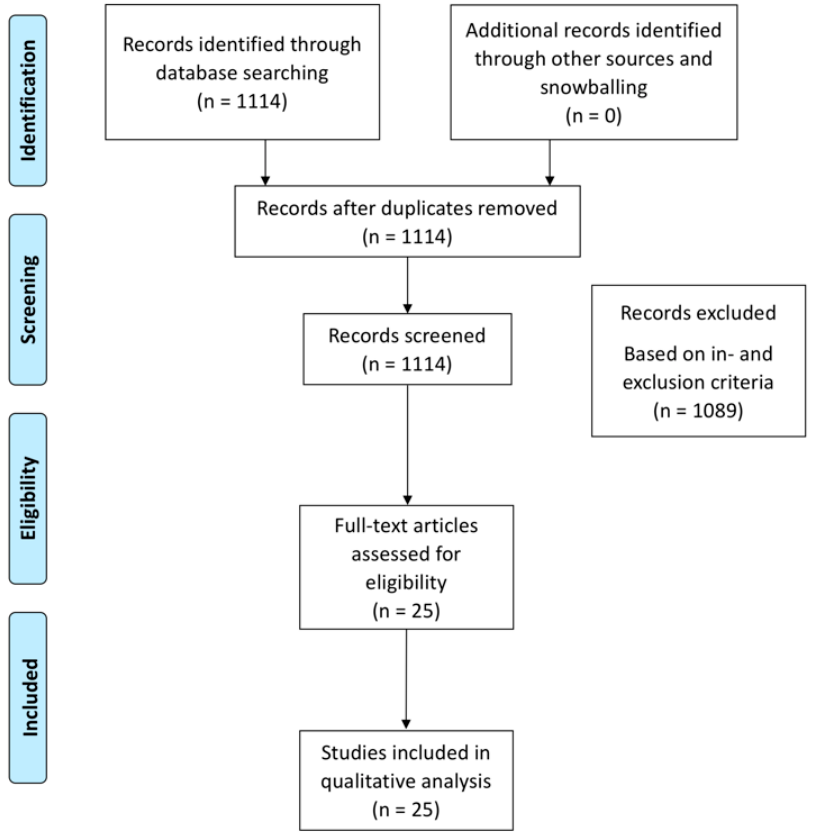
Figure 1. PRISMA flowchart showing the yield of the search and inclusion of studies leading to the 25 included studies.